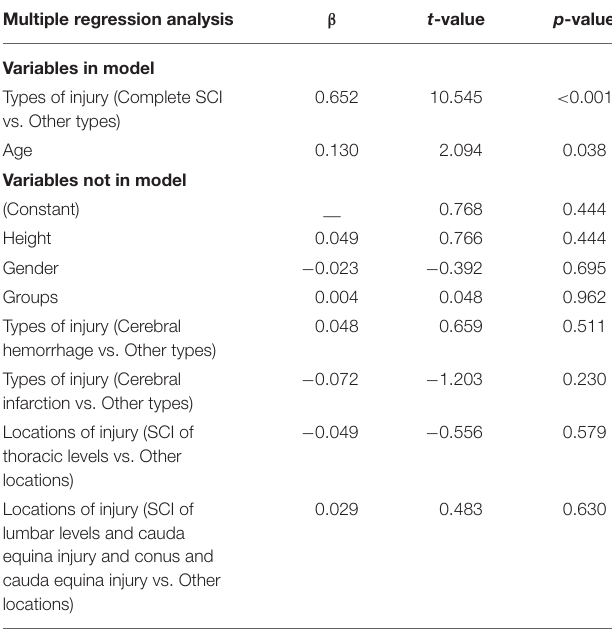
TABLE 8 | Multiple regression analyses predicting VPTs for participants with stroke and